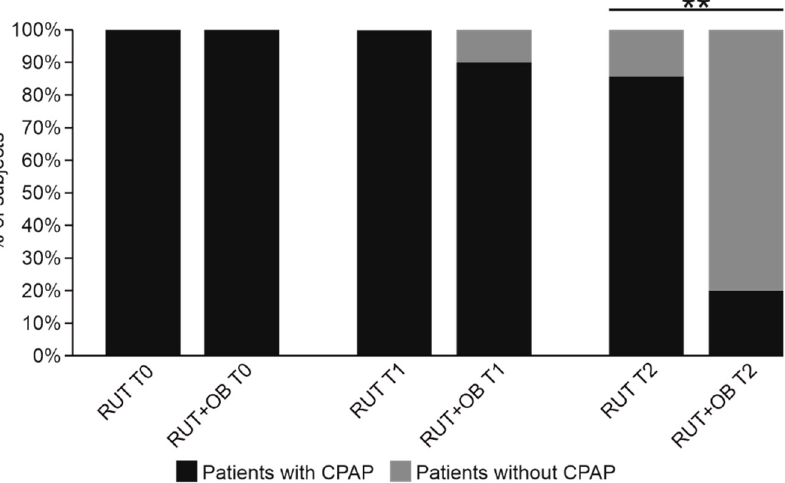
Figure 2. Distribution of patients with CPAP between groups at different time points. Data are represented as boxplots showing median, IQR (25–75%). **: p ≤ 0.001. Table 1. Distribution of demographic and clinical variables between groups. A p -value ≤ 0.05 was considered statistically